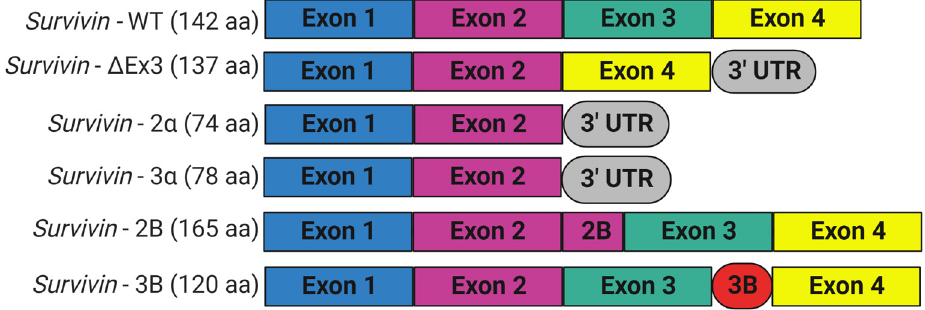
Figure 3. Schematic representation of alternative splice variants of survivin encoded by BIRC5 gene. Six different variants were identified. The wild-type survivin with four exons: survivin- Δ Ex3 lacks exon 3 and shows a frameshift with the extension of the reading frame into the open reading frame of the 3 ′ untranslated region; survivin-2 α and survivin-3 α have exon 1 and 2; survivin-2B has an additional exon (exon 2B) inserted between exon 2 and 3; and survivin-3B has a novel exon (exon 3B) flanked by exon 3 and 4. This figure was created with BioRender.com.